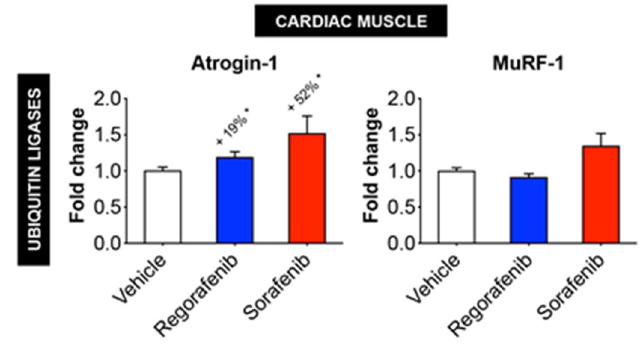
Figure 7. MKIs determine increased expression of cardiac Atrogin-1, whereas MuRF-1 is unchanged. mRNA expression for Atrogin-1 and MuRF-1 in the cardiac muscle of mice treated with 30 mg / kg / day regorafenib (blue; n = 8), 60 mg / kg / day sorafenib (red; n = 8), or vehicle (white; n = 8) over the course of 6 weeks. Data presented as mean ± SEM. Significance of the difference: * p < 0.05 vs. Vehicle.